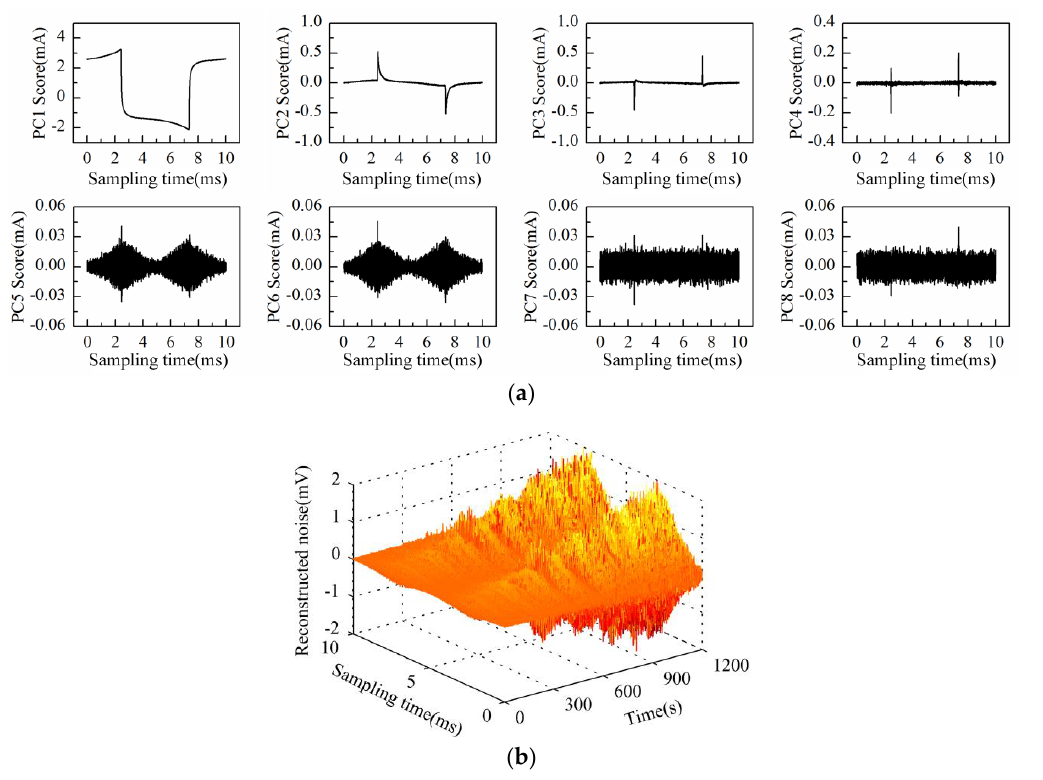
Figure 7. Measurement results of KCl solution conductivity variation process conducted with Au-IDT: ( a ) PC1–PC8 scores plot; ( b ) 3-D image of the reconstructed noise in one sampling period.